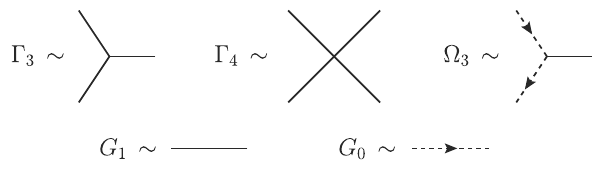
Fig. 1 Diagram technique elements